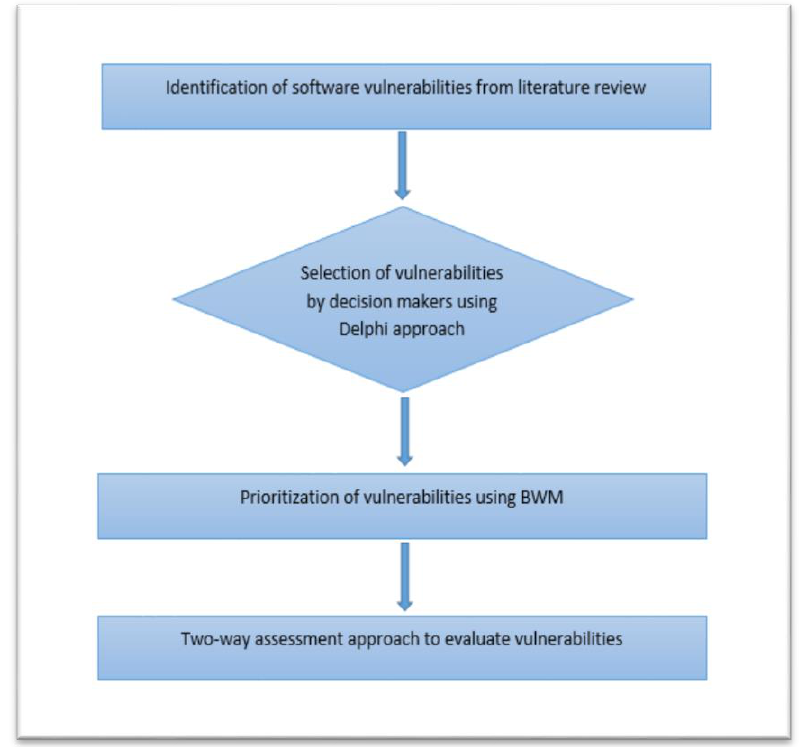
Figure 1: Graphical representation of research